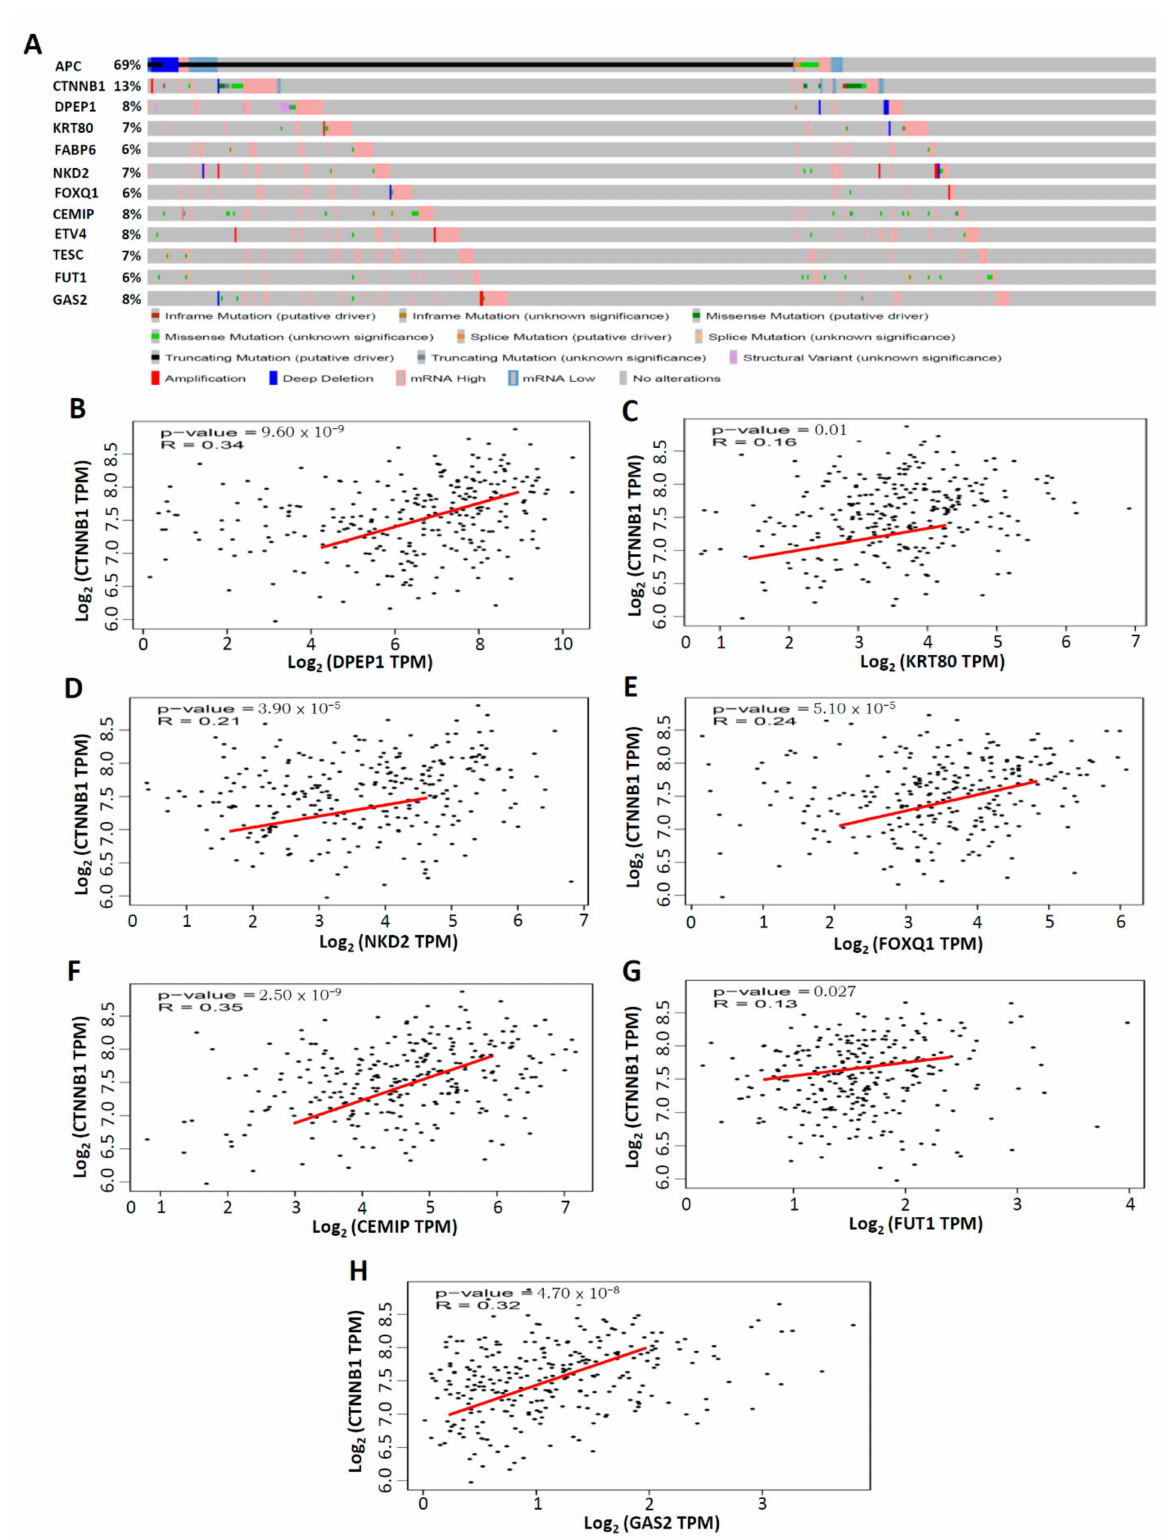
Figure 6. Mutations of APC , CTNNB1 , and the top 10 upregulated CRC-associated genes and the correlation between CTNNB1 and seven CRC-associated genes in CRC. ( A ) APC , CTNNB1 , and top 10 upregulated CRC-associated genes mutation analysis and gene expression in CRC (cBioPortal). ( B – H ) The positive correlation between CTNNB1 and seven CRC-associated genes in CRC, analyzed by GEPIA database. p < 0.05 was considered to be statistically